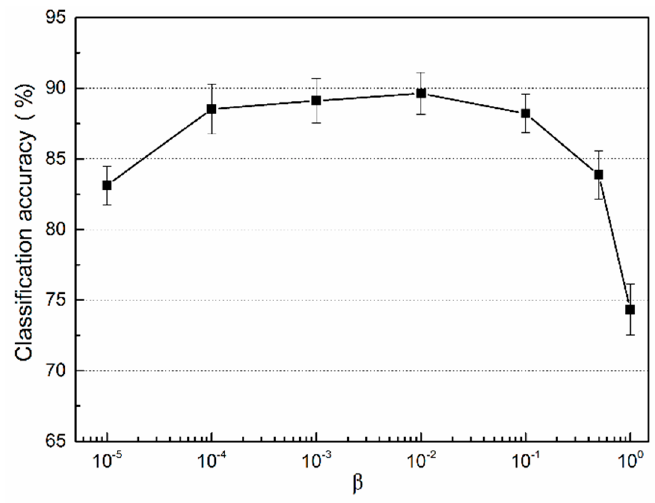
Figure 9. Evaluation of the effect on the classification accuracy of HCV of the parameter β on the LU database.